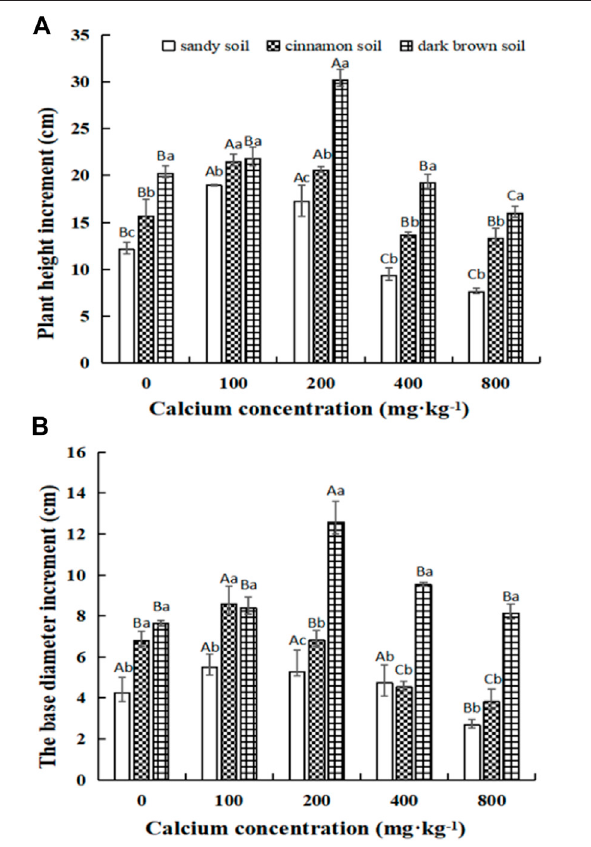
FIGURE 2 | Effect of exogenous calcium on the growth of Mongolian pine seedlings in different soil types. Note: Each column shows the average value ± SE, n = 3. Different capital letters indicate the difference between different calcium concentrations under the same soil type, and different lowercase letters indicate the difference between different soil types under the same calcium concentration ( p <